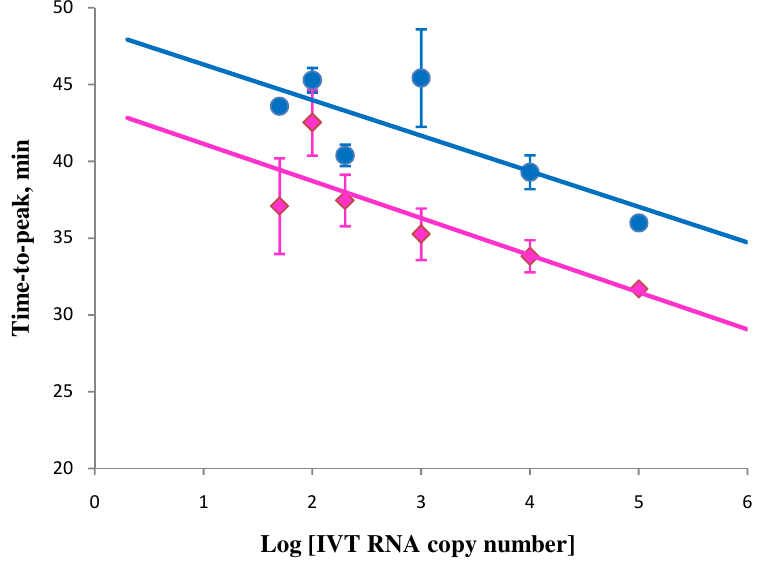
Figure 4. Correlation between amplification times in RT-STEM-LAMP (pink) and RT-LAMP (blue) and the copy number of IVT RNA in semi-logarithmic coordinates (all dilutions were measured and detected in triplicate unless indicated otherwise). Final primers concentrations were: sHIV-BIP, sHIV-FIP, HIV-StemB, HIV-StemF, HIV-BIP, HIV-FIP, HIV-LoopB and HIV-LoopF ― 1.6 µM each, HIV-DisplB and HIV-DisplF ― 0.4 µM each. Each set of data included three NTCs that remained clean throughout the duration of the assay and were not associated with any time-to-peak value (hence not shown graphically). Error bars represent standard deviations of triplicate